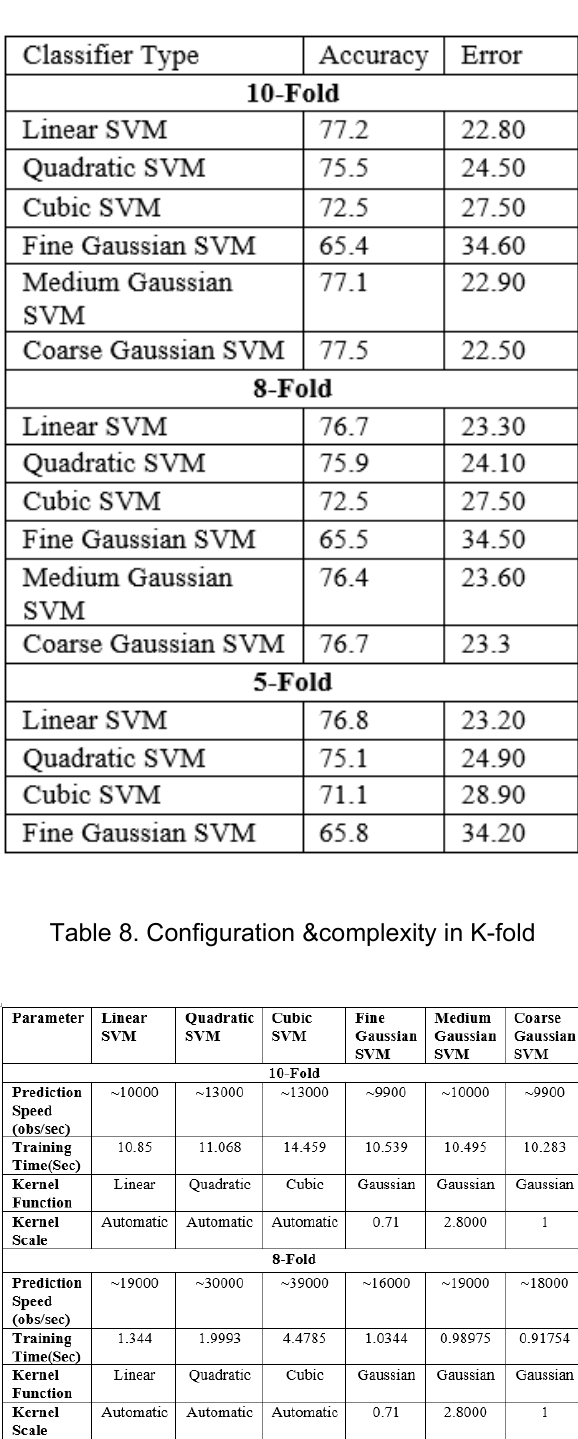
Table 6. Configuration &complexity in No Validation Table 7. K-Fold validation